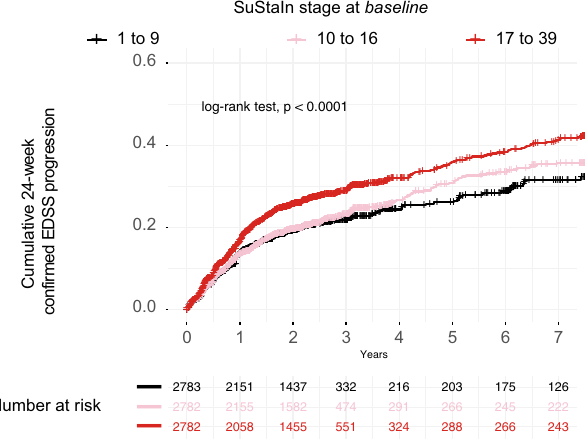
Fig. 6 Predicting treatment response with MRI-based subtyping in selected RCTs. Shows the change in EDSS worsening in MRI-based subtypes in the pooled treatment arms of the ORATORIO, ASCEND and OLYMPUS trials ( n = 2099 patients) compared to the corresponding subtypes in the pooled placebo arms (e.g., lesion-led subtype on treatment vs . lesion led subtype on placebo and so forth). Patients in the lesion-led subtype had the largest reduction in the rate of EDSS worsening and were the only group who had a signi fi cant treatment response. The circle at the centre of each line represents the model-estimated average of percentage EDSS change. Error bars represent the standard error. Abbreviations: 9HPT, 9-Hole Peg test; NAMW, normal-appearing white matter; EDSS, Expanded Disability Status Scale; RRMS, relapsing-remitting multiple sclerosis; PPMS, primary progressive multiple sclerosis; RCT, randomised controlled